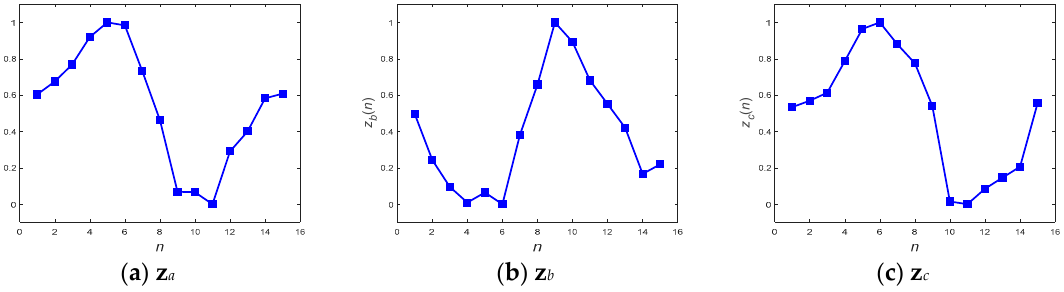
Figure 12. Convolutionally equalized preprocessed sequences z a , z b , and z c from inputs x a , x b , and x c , respectively.